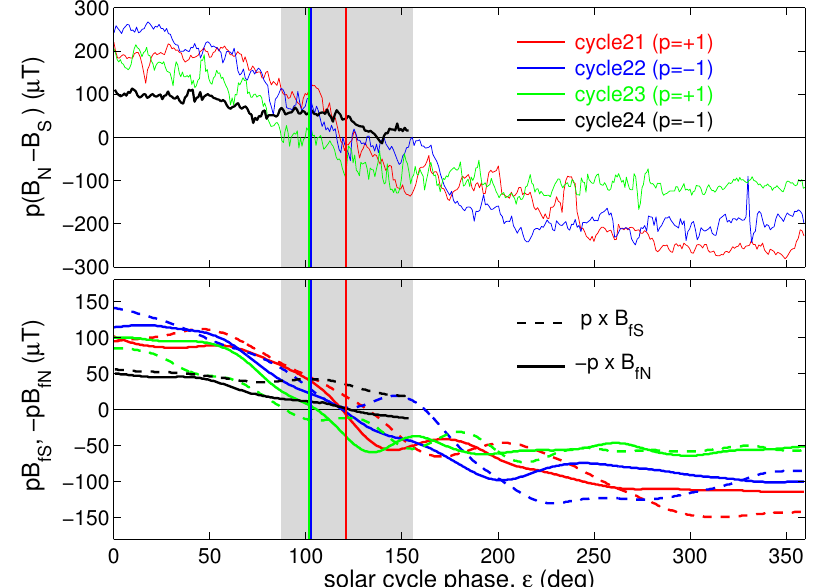
Figure 39: Solar polar fields observed by the magnetograph at Wilcox Solar Observatory (WSO) during solar cycles 21 – 24. The top panel shows the difference between the two polar fields, 𝑝 ( 𝐵 N − 𝐵 S ) as a function solar cycle phase, 𝜖 , as determined from mean sunspot latitudes using the method described by Owens et al. (2011b), where 𝐵 N and 𝐵 S are the average fields seen over the north and south solar poles, respectively, and 𝑝 = +1 for odd-numbered cycles and 𝑝 = − 1 for even ones. The reversals all occur within the grey band and the phases of the peak sunspot number in 12-month running means are given by the vertical lines. The lower panel shows − 𝑝𝐵 fN (solid lines) and 𝑝𝐵 fS (dashed lines) as a function of 𝜖 where 𝐵 fN and 𝐵 fS are the 𝐵 N and 𝐵 S data that have been passed through a 20 nHz low-pass filter. In both panels, red, blue, green and black denotes solar cycles SC21, SC22, SC23, and SC24, respectively. This plot will be updated regularly as the cycle progresses: this version was generated on 20 April